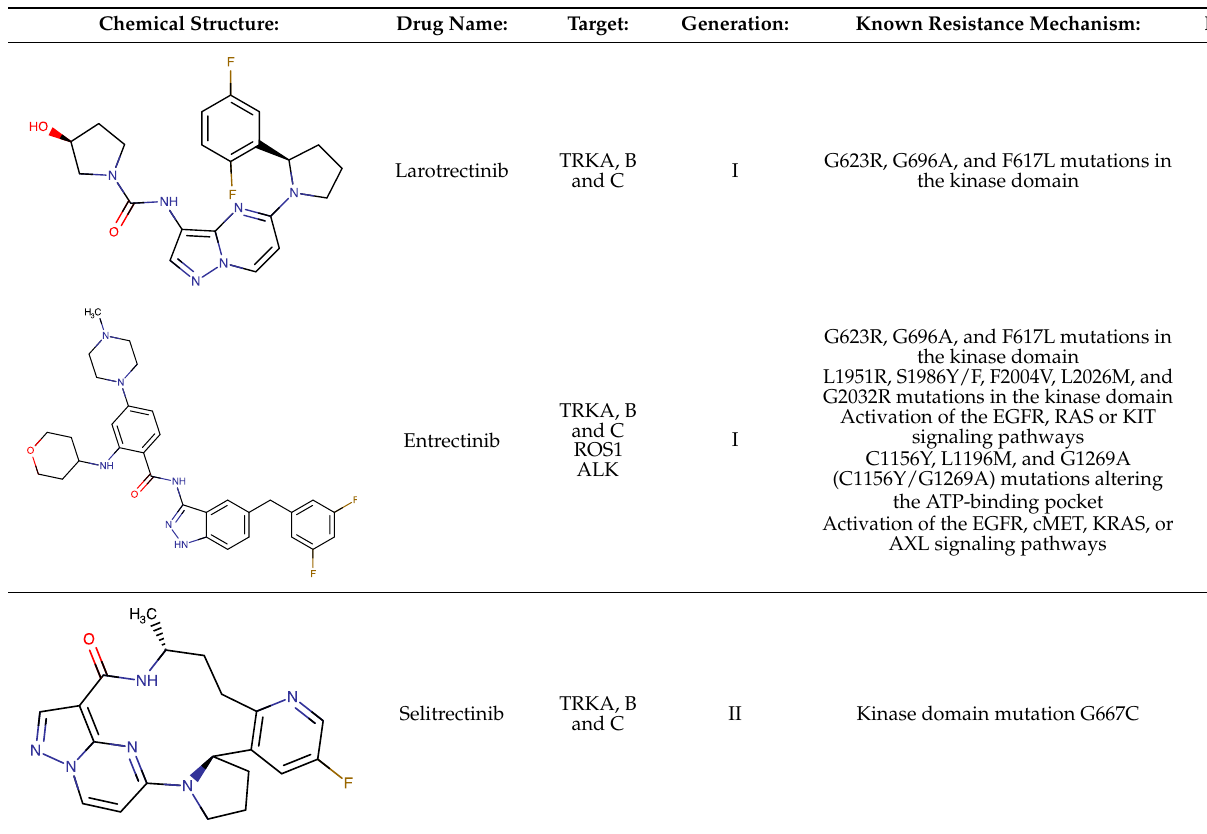
Table 2. Multikinase inhibitors currently available.